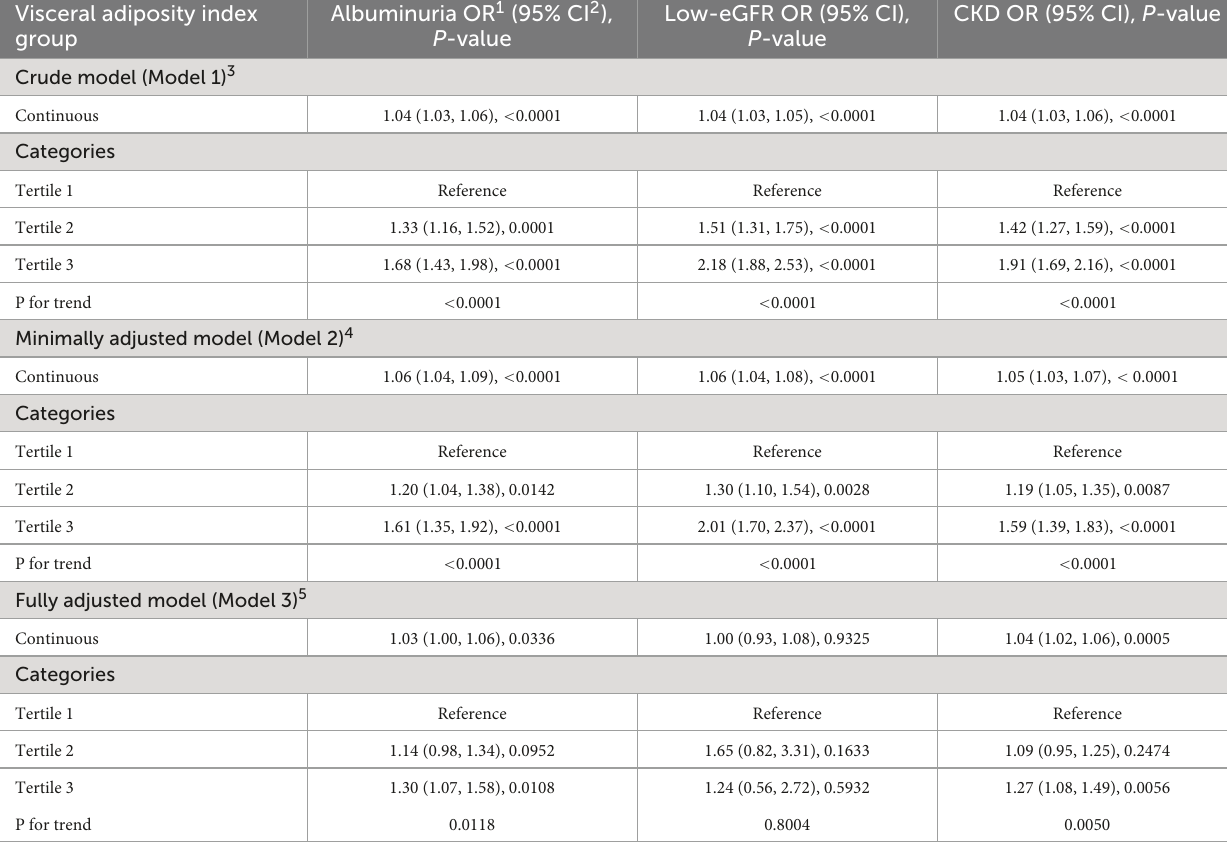
TABLE 2 Association between visceral adiposity index and decreased renal function. Visceral adiposity index group